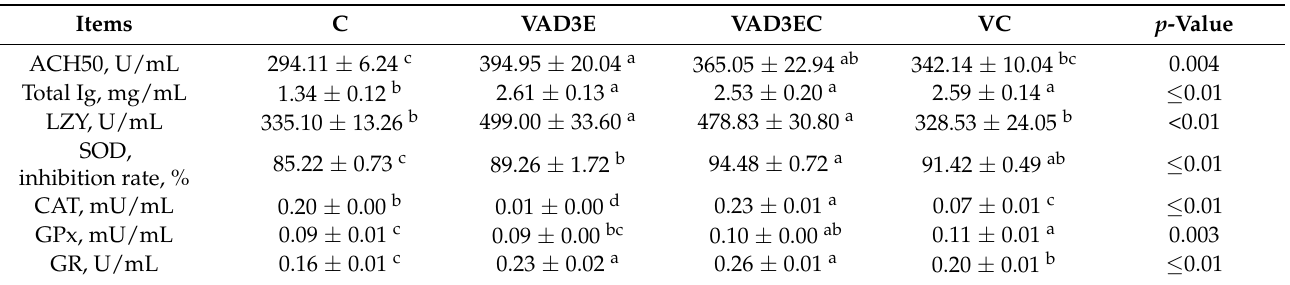
Table 5. Effects of various vitamins on immune and antioxidant activity levels in serum samples from dairy cows over 14 days.